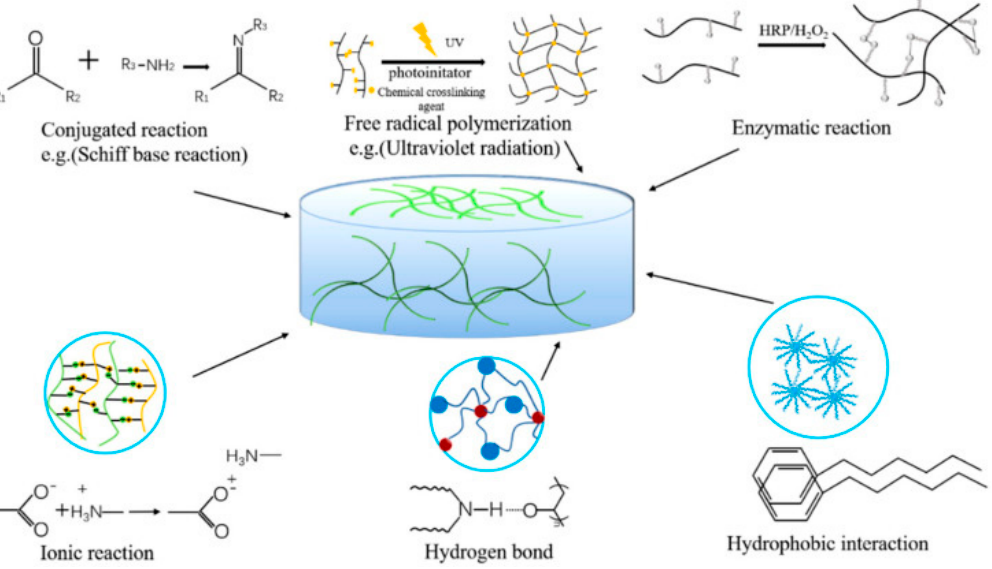
Figure 1. Physical and chemical crosslinking methods to prepare hydrogel systems for biomedical application